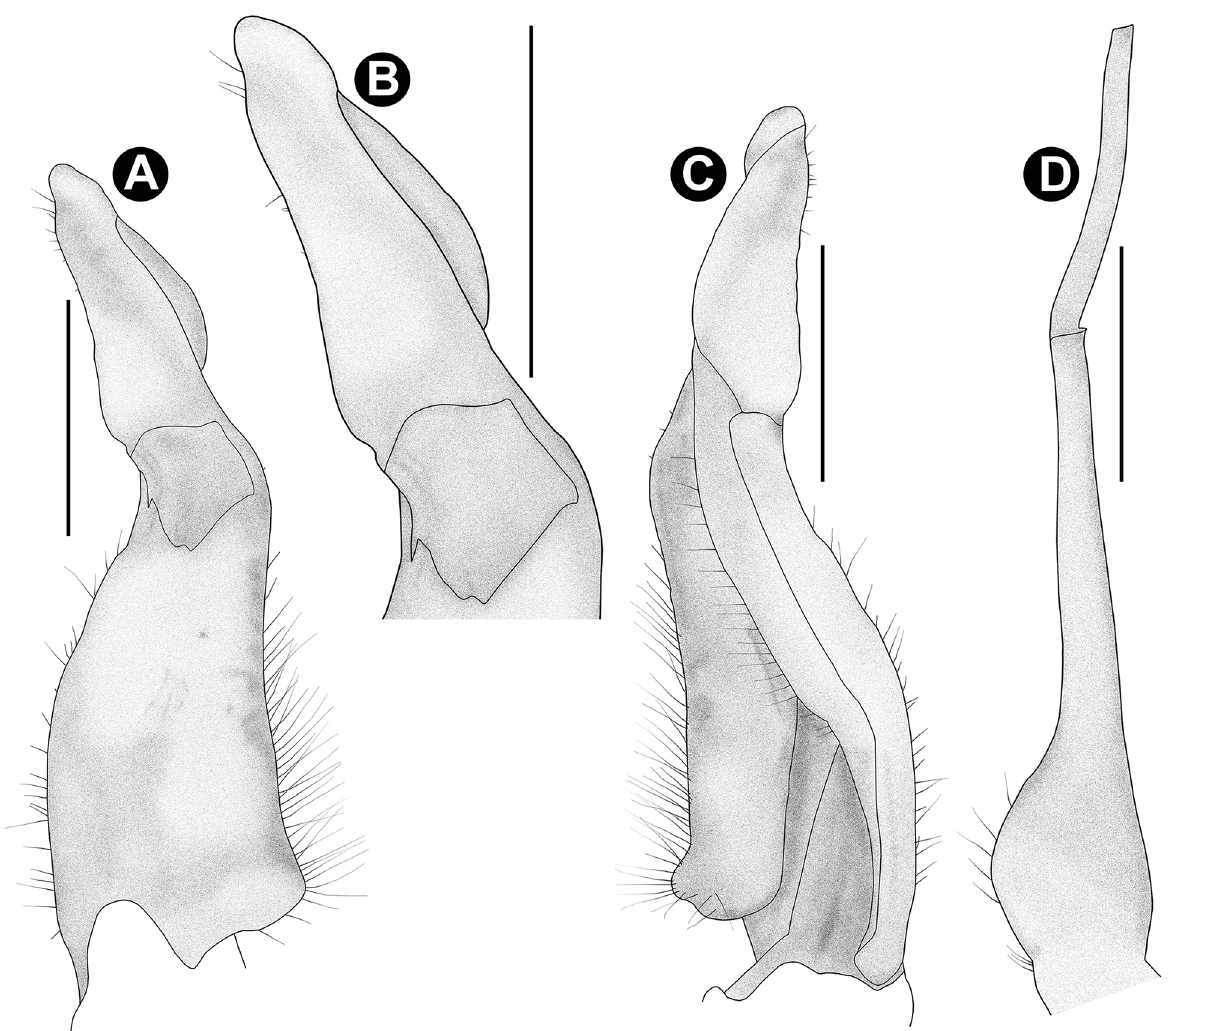
Figure 3. Abormon praecalvum sp. nov., holotype male (12.9 × 10.5 mm) (ZSI-WRC C.1941). A , dorsal view of left G1; B , dorsal view of left G1 terminal segment; C , ventral view of left G1; D , left G2. Scale bar = 1